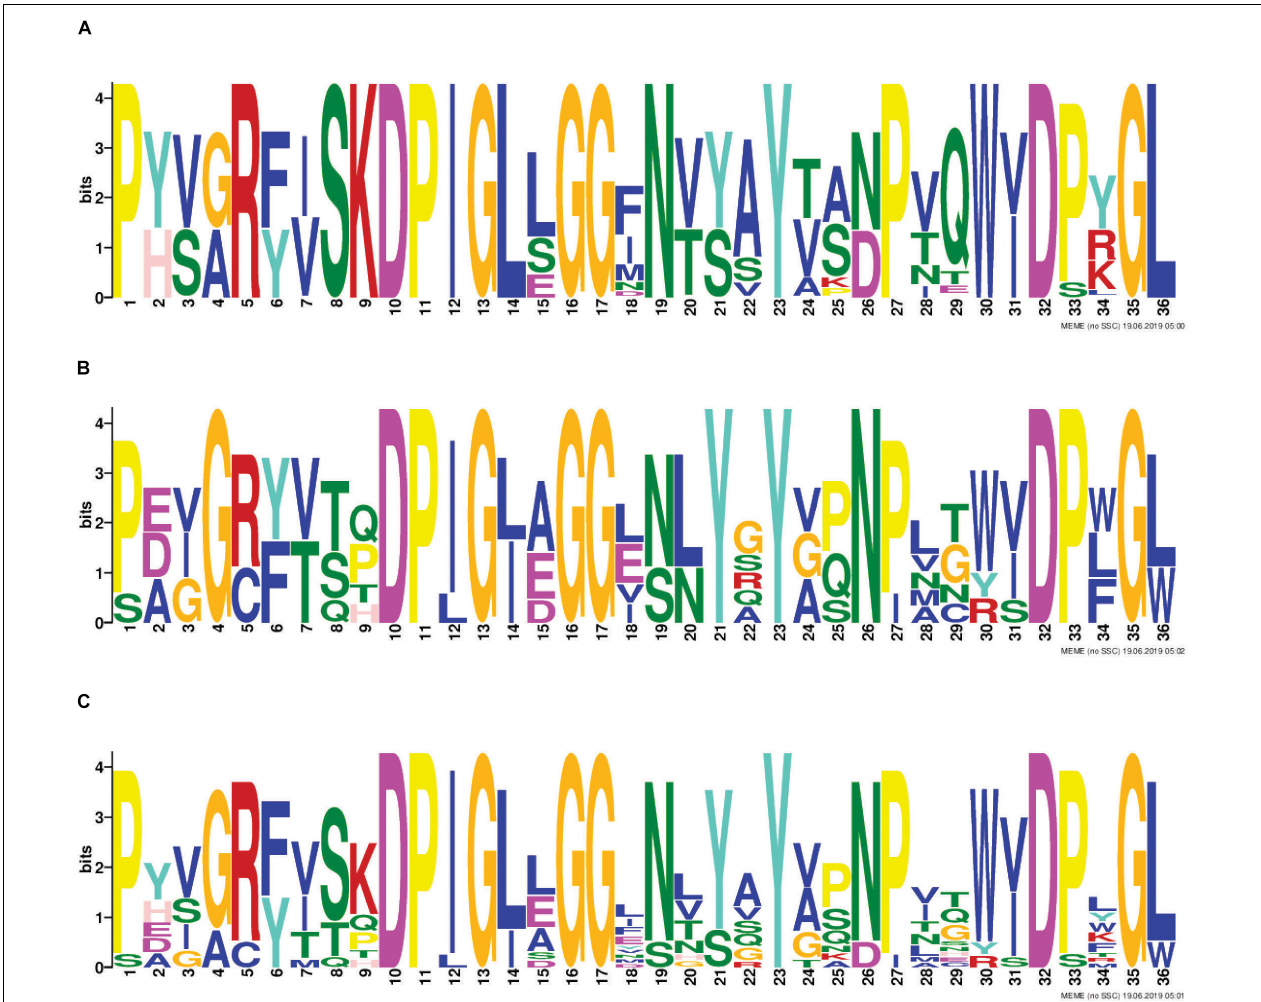
FIGURE 5 | Identification of conserved amino acids surrounding the putative RHS cleavage motif. The 36 amino acids immediately upstream of where the C-terminal toxic domain is predicted to be cleaved from the N-terminal RHS domain of all RHS effectors included in this study, were used for identification of conserved residues using the Multiple EM for Motif Elicitation (MEME) (Bailey and Elkan, 1994). Conserved region in all T6SS-associated A. baumannii RHS proteins identified from analysis of; all RHS proteins in the 97 A. baumannii genomes (A) , representative non- A. baumannii RHS proteins (B) and in both A. baumannii and non- A. baumannii RHS proteins (C) . The amino acid position is shown on the X -axis, and the bit-score showing probability of each of the amino acids at each position is shown on the Y